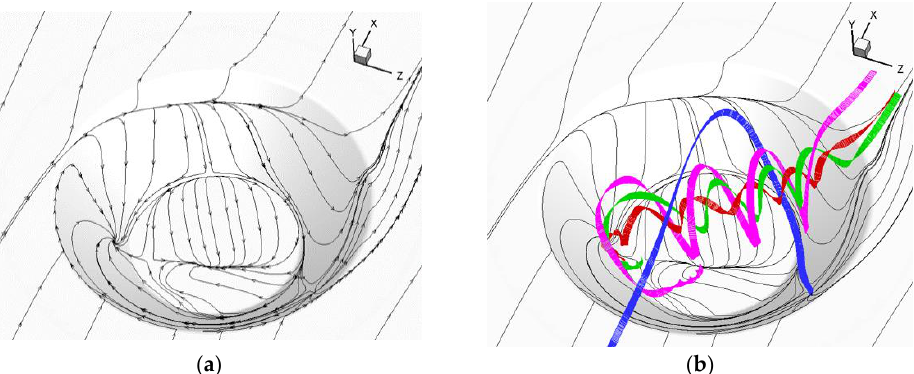
Figure 2. Air source streamlines on the wall surfaces of the channel with a conical dimple ( a ) and the vortex structure ( b ).